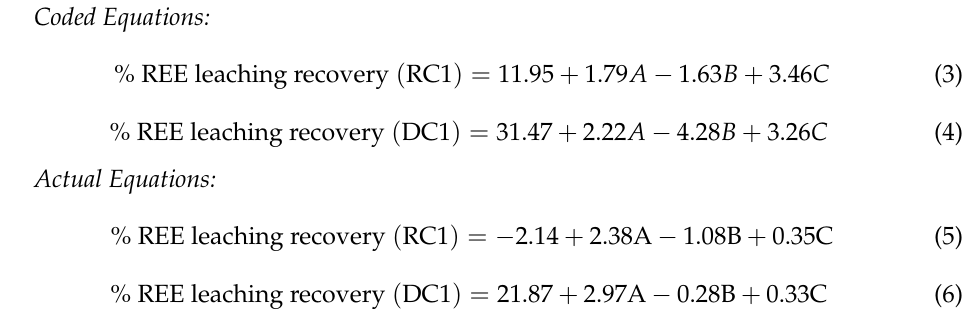
Figure 3. 3D surface plots of the relationship between leaching temperature, pulp density (solid:liq ‐ uid ratio), and their impact on the % REE leaching recovery for RC1 ( A ) and DC1 ( B ) coals.